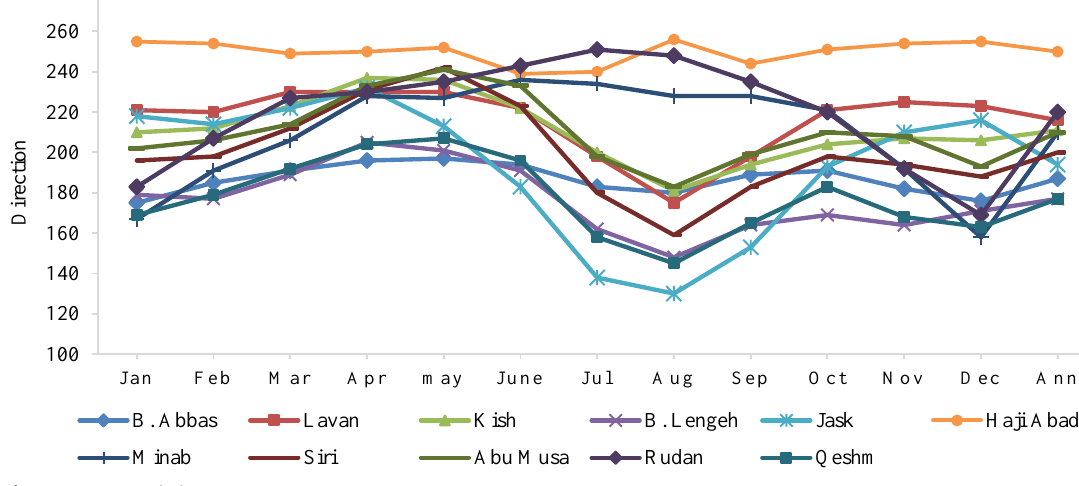
Figure 6. Wind direction in stations